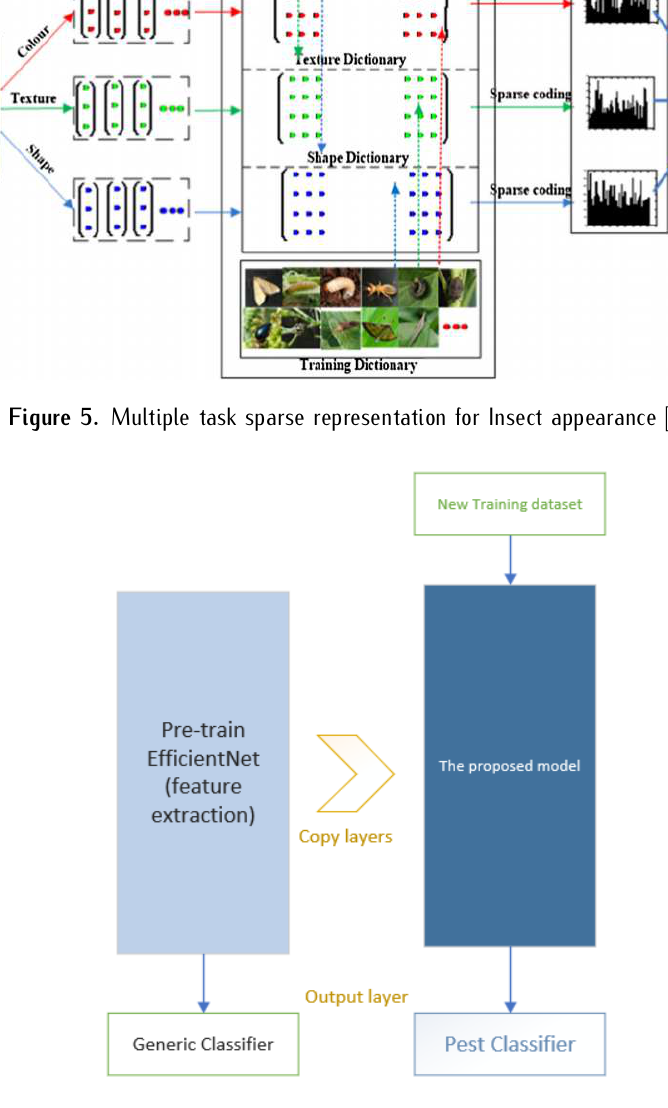
Figure 6. The proposed DL architecture, fine tuned from EfficientNet.